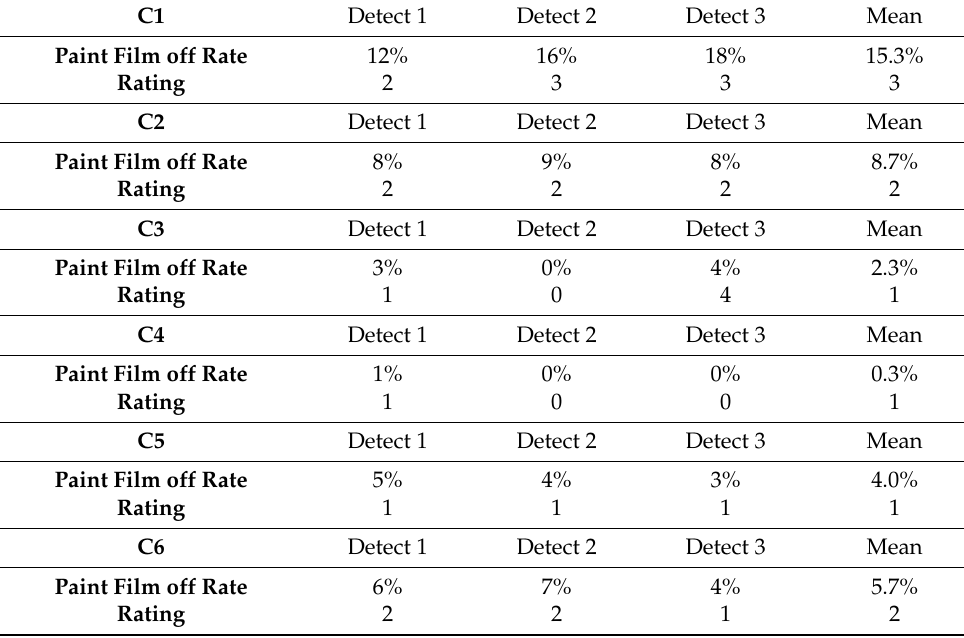
Table 11. The measured value of adhesion of paint film for Group